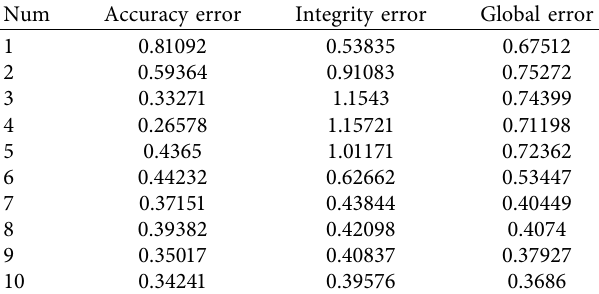
Table 1: Quantitative test results of 3D reconstruction quality. Num